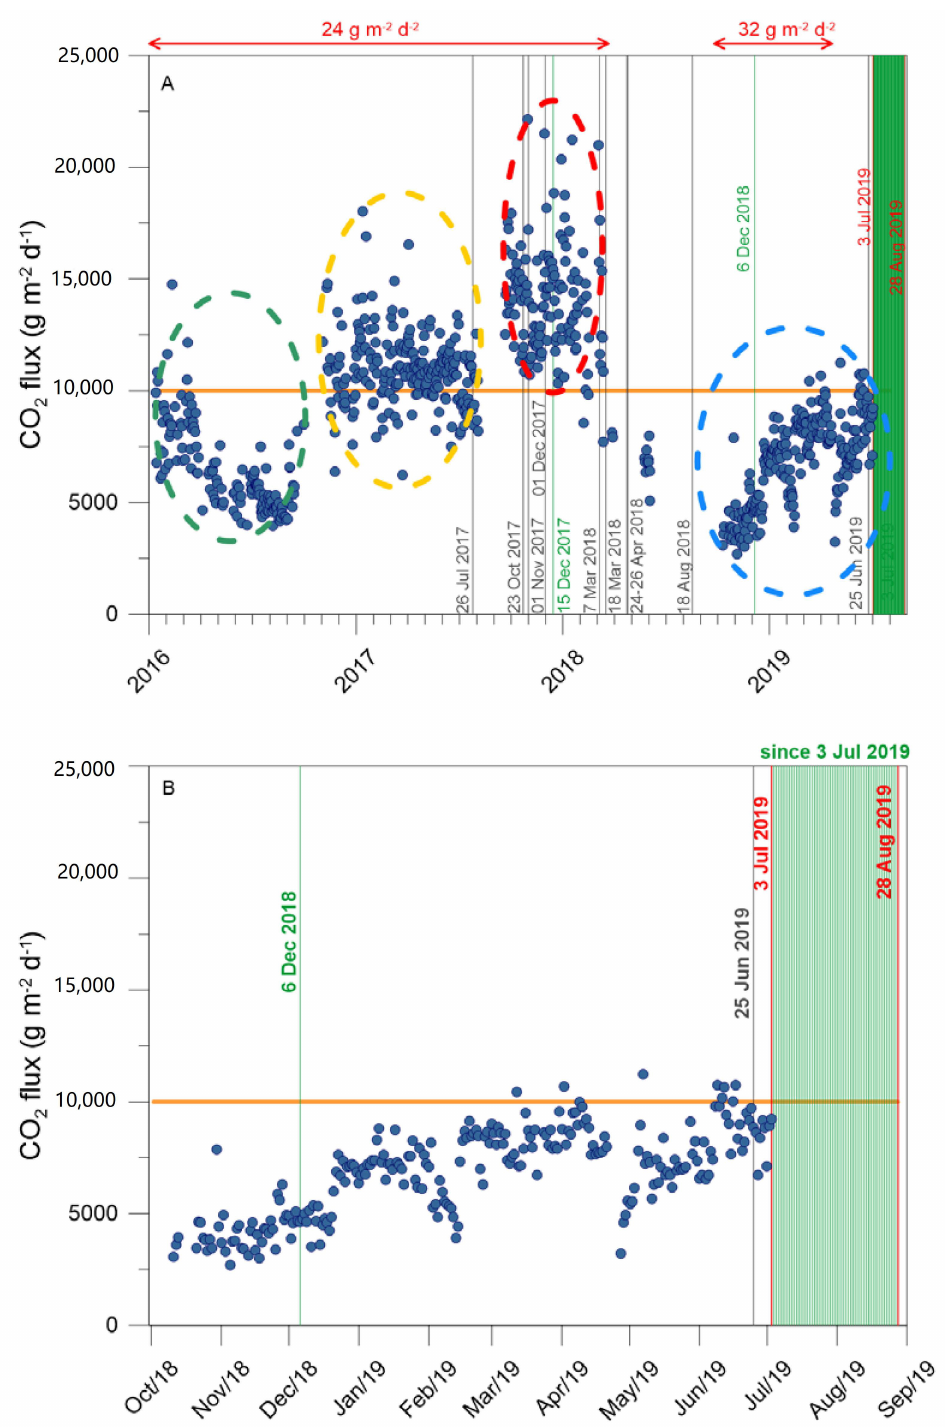
Figure 2. ( A ) Daily average of CO 2 fluxes at STR02 station expressed in g m 2 d − 1 of the 2016–2019 period. Two abrupt increasing of CO 2 flux has been recorded. The green-yellow and red dashed circle indicating the first abrupt increasing of CO 2 fluxes (24 g m 2 d − 2 ) occurred in the 2016–2018 period; The dashed blue circle indicates the second abrupt increasing of CO 2 fluxes (32 g m 2 d − 2 ) occurred from October 2018 to July 2019.The threshold value of 10,000 g m 2 d − 1 of CO 2 fluxes (orange line) have been reported; ( B ) Inset of daily average of CO 2 fluxes from October 2018 to July 2019; the threshold value of 10,000 g m 2 d − 1 of CO 2 fluxes (orange line) have been reported. Colored vertical lines represent main paroxysms (red), major explosions (grey), and overflows